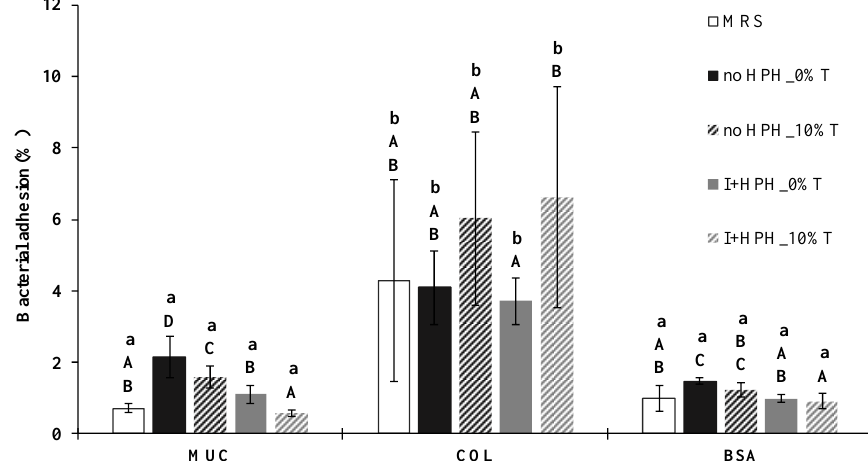
Figure 3. L. salivarius spp. salivarius CECT 4063 adhesion to mucin (MUC), collagen (COL) and bovine serum albumin (BSA) depending on the growth media composition and/or the homogenization at 100 MPa. Error bars represent the standard deviation of 6 replications. a – b For the same growing media and A – D for the same protein indicate statistically significant differences with a 95% confidence level ( p < 0.05).